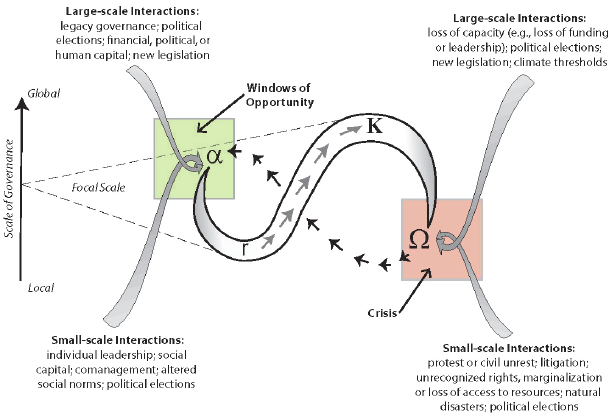
different scales. For example, policies and trajectories at national and regional scales can facilitate or constrain change at smaller scales, and vice-versa (e.g., Wheeler 2000). Different scales can also change at different rates (e.g., Larson et al. 2013). Fig. 3 . Adaptive governance cycle. Representation of dynamic cycles of change (“adaptive cycles”) that social-ecological systems (SESs) may undergo: exploitation (r), societal, organizational, or community preference for a particular governance paradigm; conservation (K), consolidation and entrenchment of a preferred paradigm or governance regime; crisis or release (Ω), shortcomings and failures that lead to paradigm collapse; reorganization ( α ), opportunity for innovation, which may restructure or transform existing paradigms, yielding novel governance arrangements (emergence, adaptation). Windows of opportunity represent emergence frontiers (Fig. 2), for particular centers of activity (Fig. 1), in a linked SES. Change forces exerted by small and large-scale linkages may be described by panarchy, whereas their legal and institutional dynamics may be described by institutional theory, such as Ostrom Institutional Analysis. Adapted from Chaffin and Gunderson